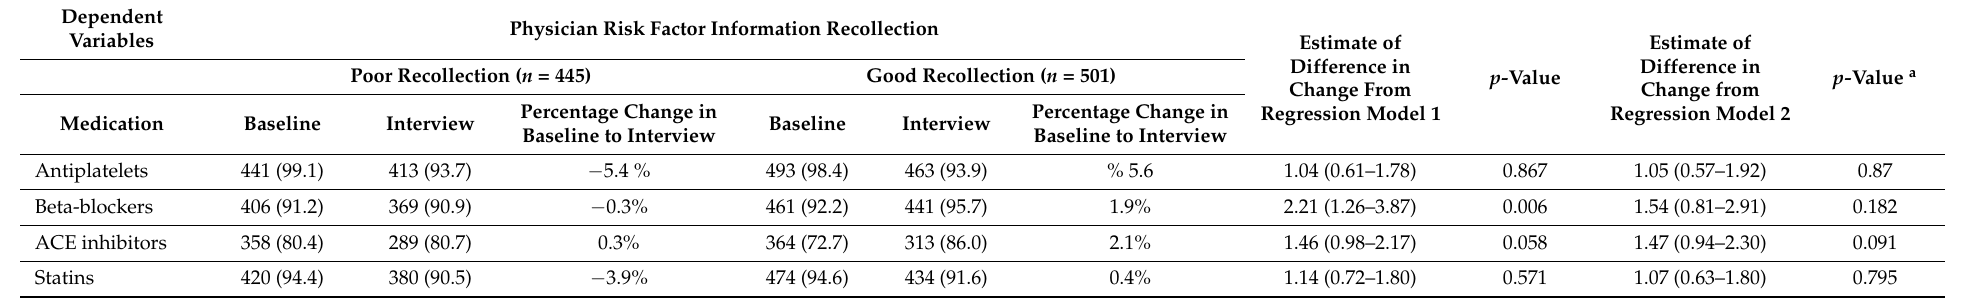
Table 4. Change in Medication Intake Compared with the Status of a Physician’s Risk Factor Information Recollection in Chronic Coronary Syndrome